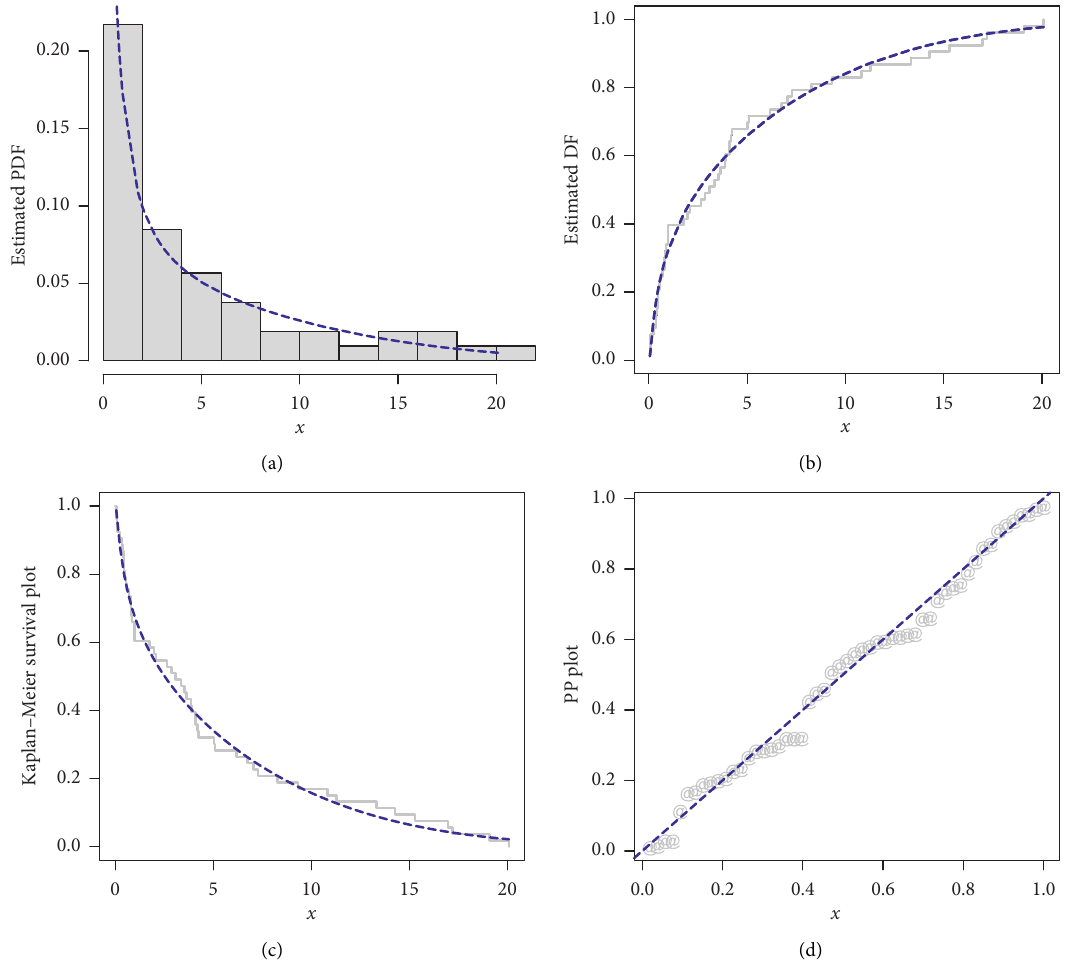
Figure 9: The (a) estimated PDF, (b) estimated DF, (d) PP, and (c) Kaplan–Meier survival plots of the ASNFEW distribution for the COVID-19